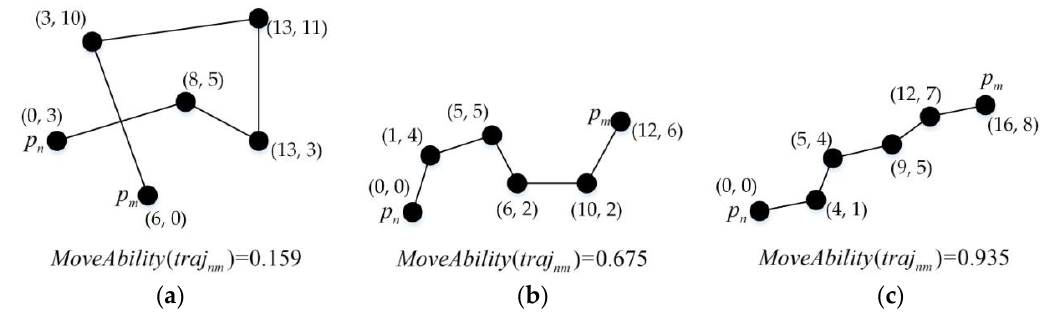
Figure 2. Examples of move ability. ( a ) The activity at a stop; ( b ) movement on curved roads; ( c ) linear motion.